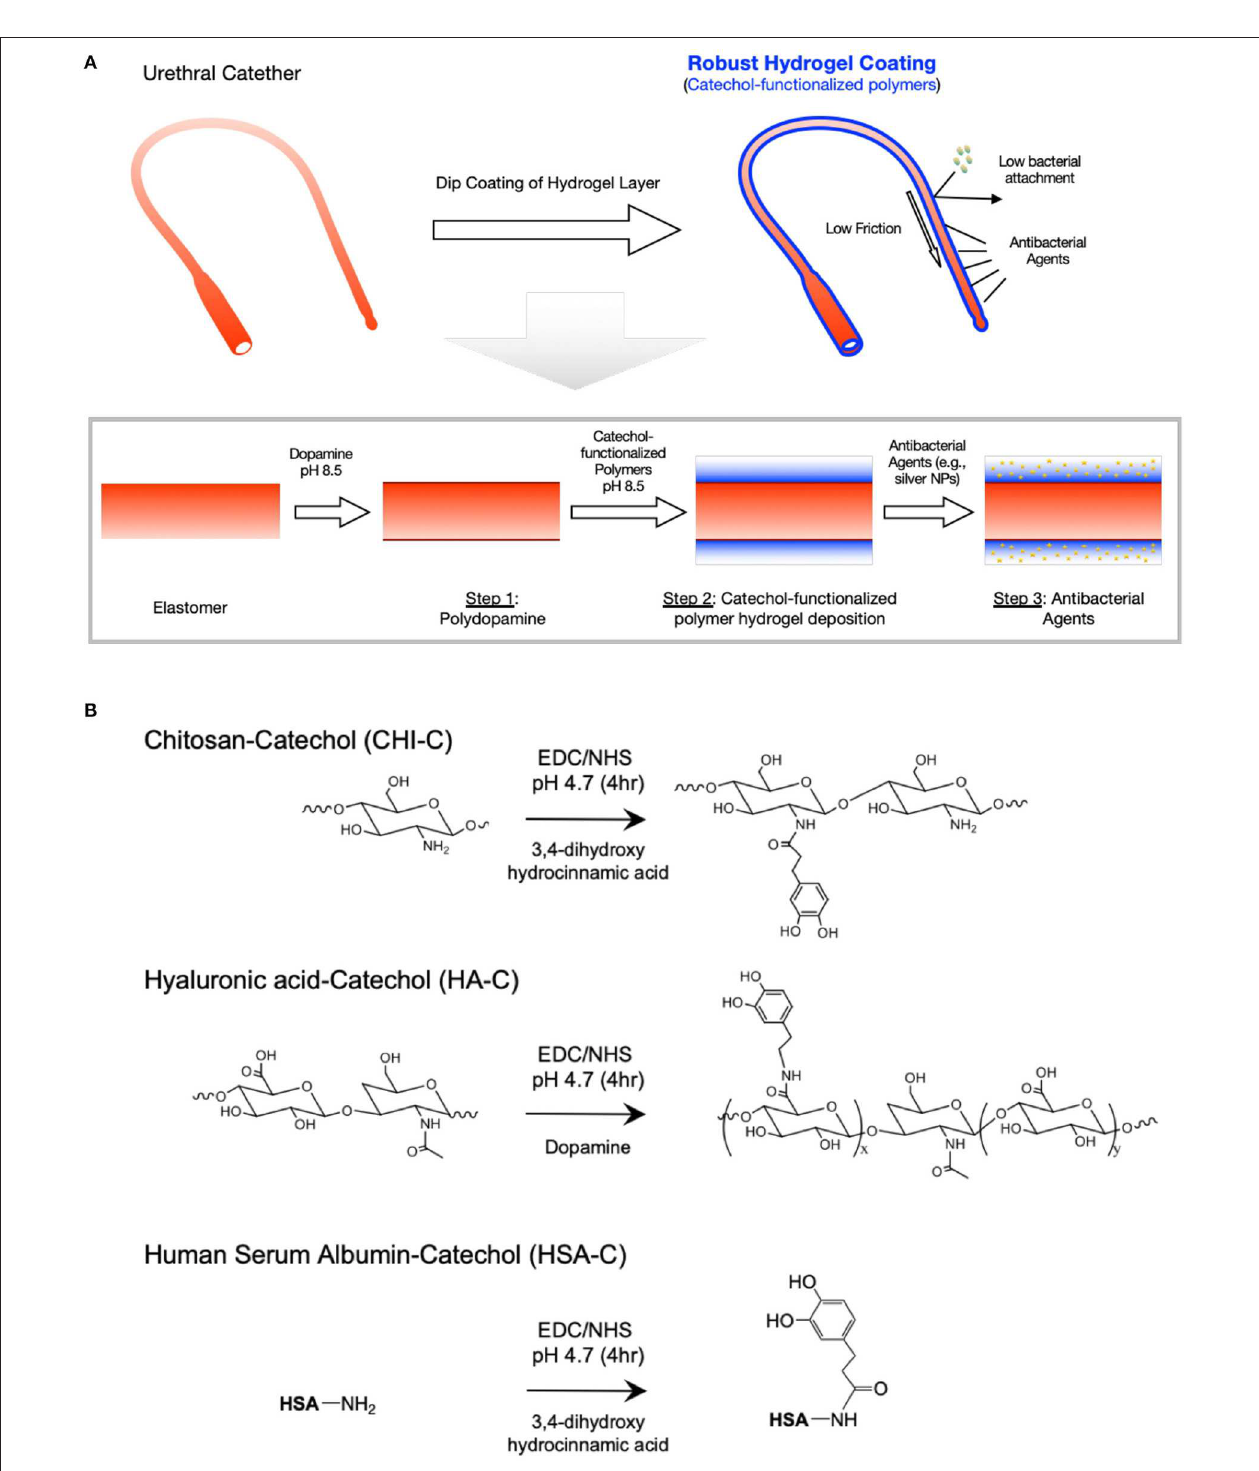
FIGURE 1 | Catechol-functionalized polymer hydrogel surface modification for urethral catheters. (A) Schematic illustration of the hydrogel deposition on urinary catheter tubing with low friction, low bacterial adhesion and antibacterial effect with silver nanoparticles (AgNPs). To immobilize antibacterial coatings on the elastomers, a three-step process was used: (1) surface priming using polydopamine coating, (2) polymer deposition using catechol-functionalized biomacromolecules, and (3) loading of antibacterial agents (e.g., AgNPs). (B) Synthesis schemes of catechol functionalized chitosan (CHI-C), hyaluronic acid (HA-C), and human serum albumin (HSA-C) using EDC mediated